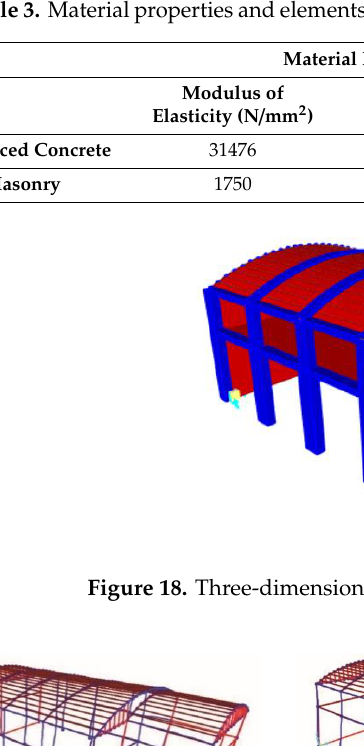
Table 3. Material properties and elements type adopted in the Finite Element (FE) models—Structure A.